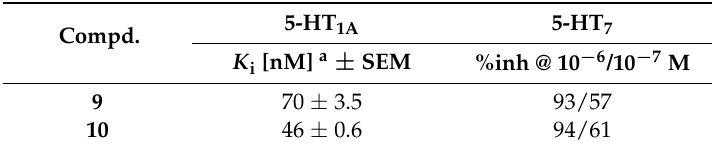
Table 3. The binding data of selective compounds for 5-HT 1A and 5-HT 7 Rs. Compd.